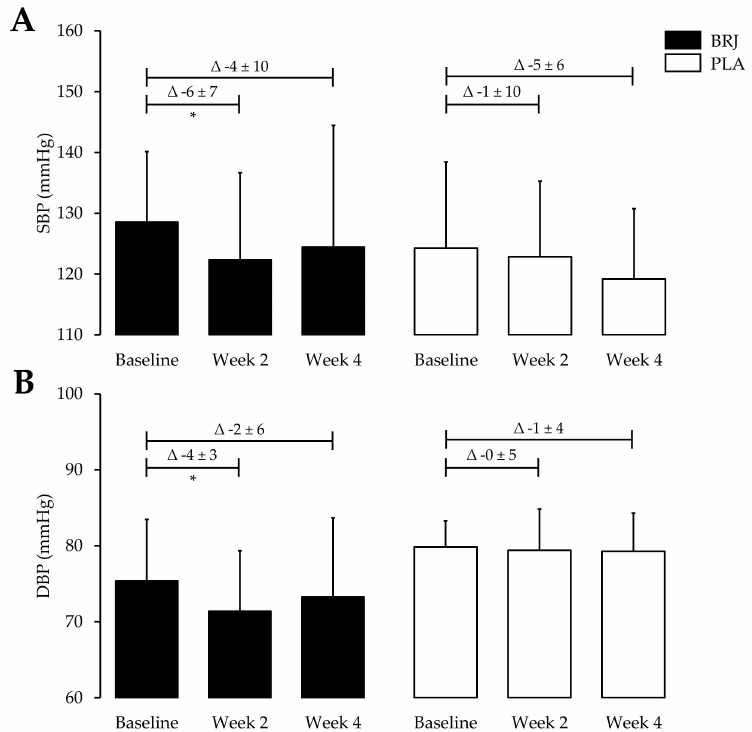
Figure 3. The e ff ects of four weeks of BRJ consumption or PLA on BP. Beetroot juice consumption reduces ( A ) SBP and ( B ) DBP in healthy older adults. Data are expressed as mean ± SD. * Significance shown for comparisons within treatment allocations of the change between baseline, week 2 and week 4, p < 0.05 for a Bonferroni post hoc test. BRJ = beetroot juice; DBP = diastolic blood pressure; PLA = placebo and SBP = systolic blood